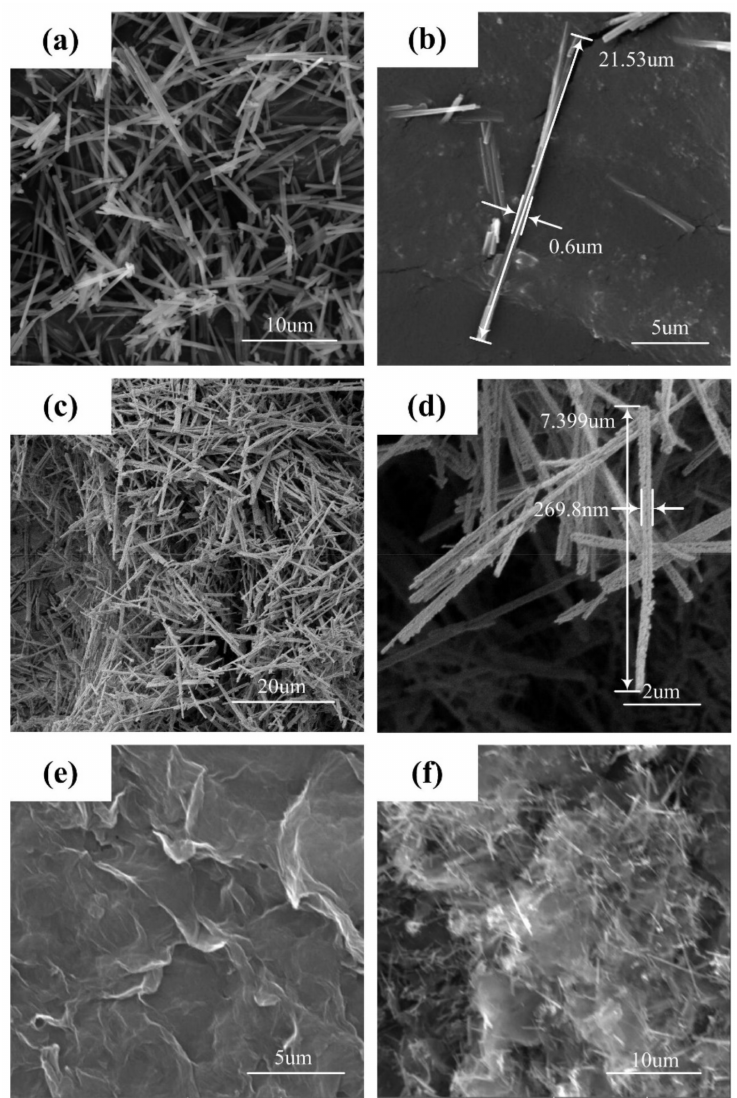
Figure 2. SEM images of the as-prepared powders: ( a , b ) Co/Ni/Fe composite oxalate fibers;